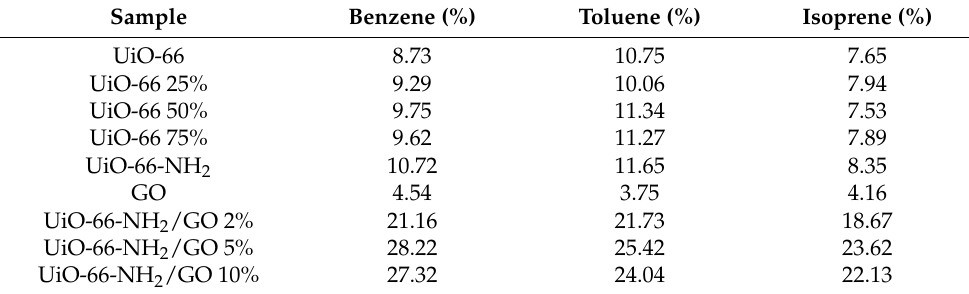
Table 5. Other components removal efficiency in cigarette smoke.